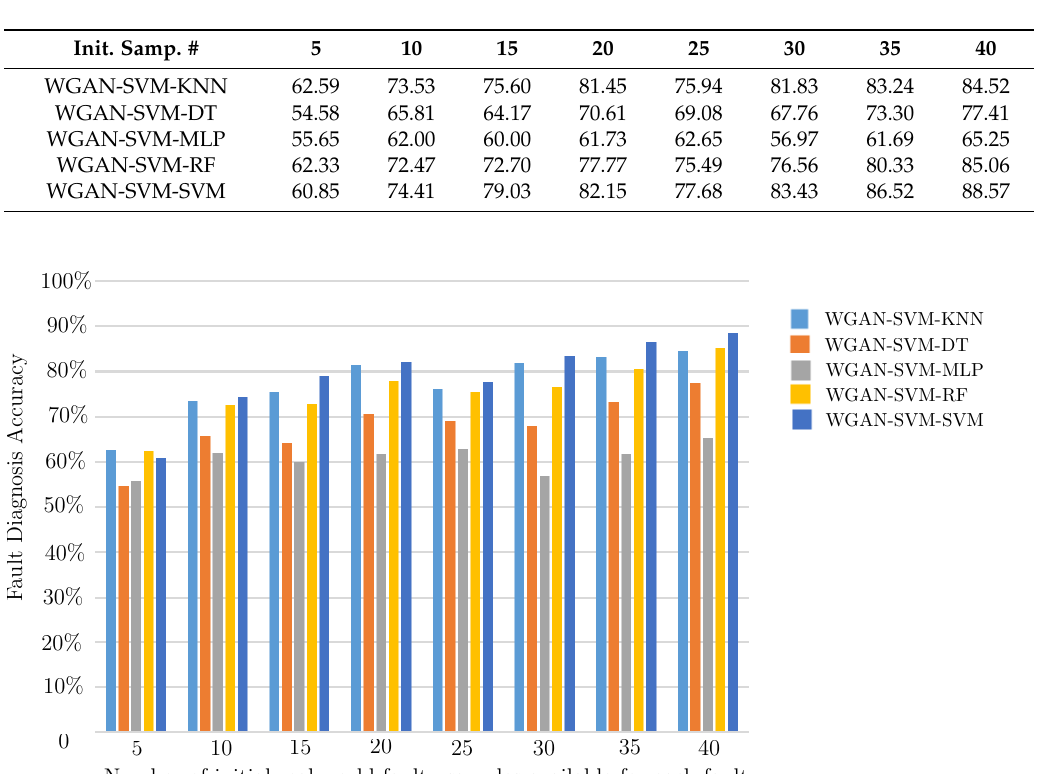
Table 3. The fault diagnosis accuracy rates (%) with different classifiers using WGAN-SVM to generated artificial training dataset.